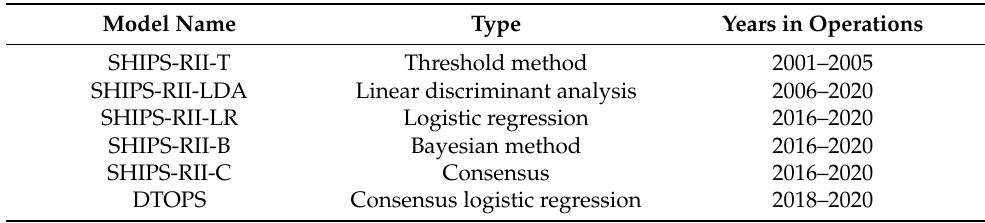
Table 3. NHC’s probabilistic RI